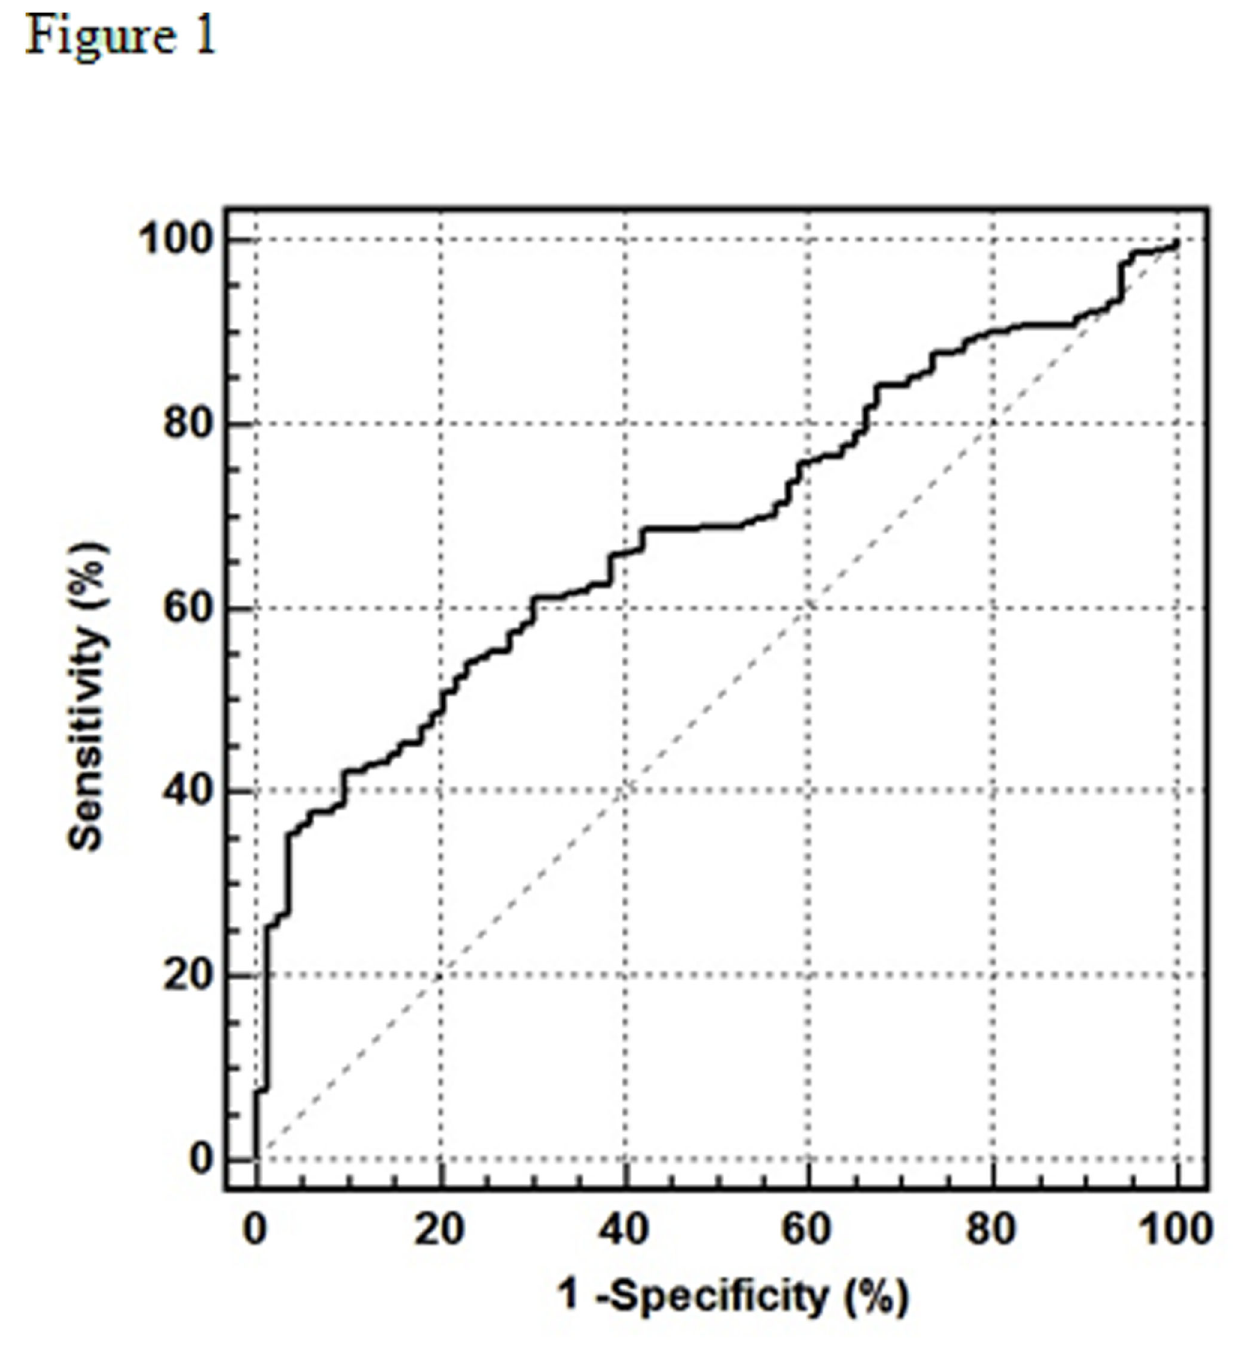
Figure 1. Receiver operating characteristic (ROC) curve for the optimal haptoglobin concentration cut-off for identifying the presence / absence of coronary artery disease. doi: logistic regression model, the -2ln likelihood ratio was 354.2 without the inclusion of Hp concentration as a variable and 327.8 with the inclusion of Hp concentration as a variable.